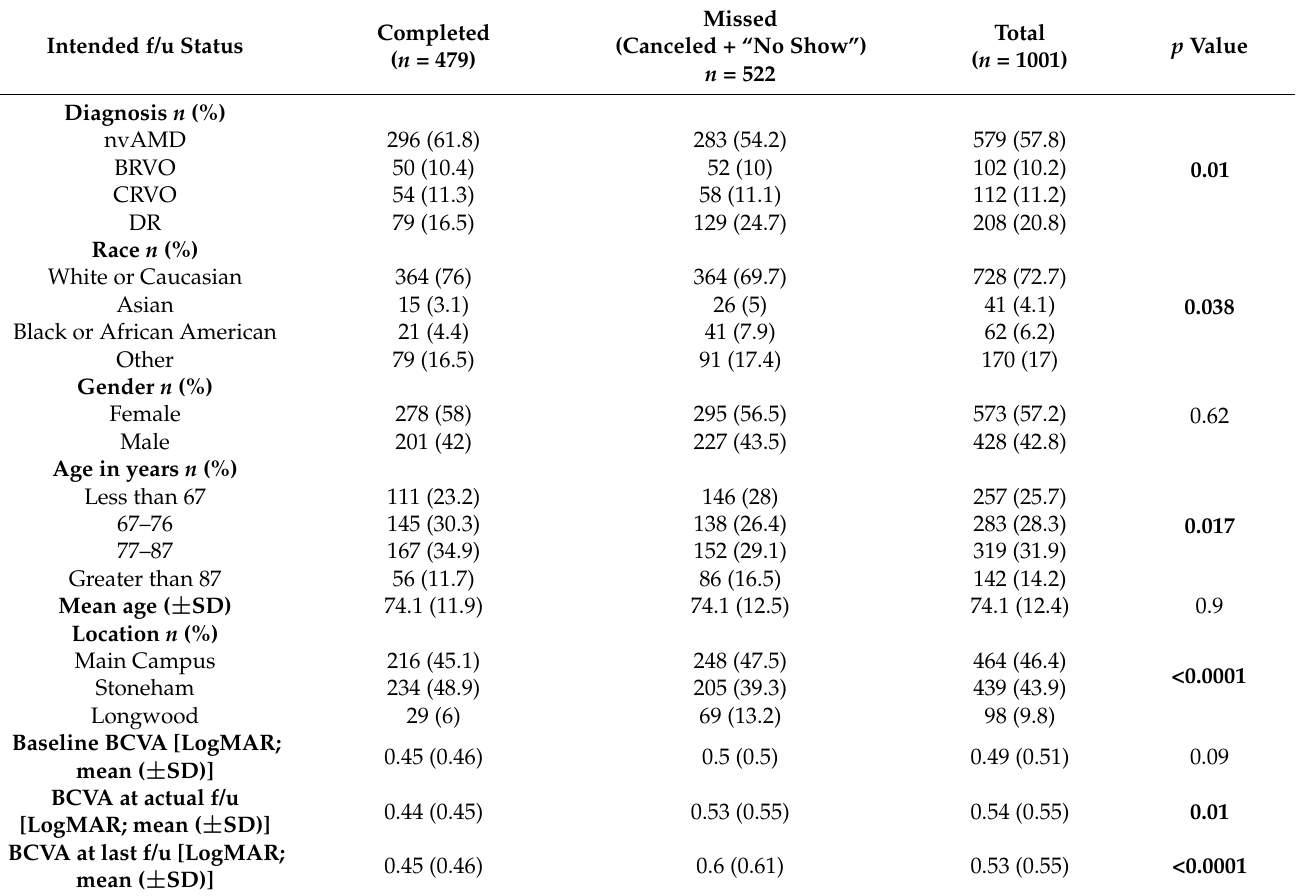
Table 1. Demographic characteristics of the cohort based on the intended f/u status [Completed, Missed (Canceled + “no